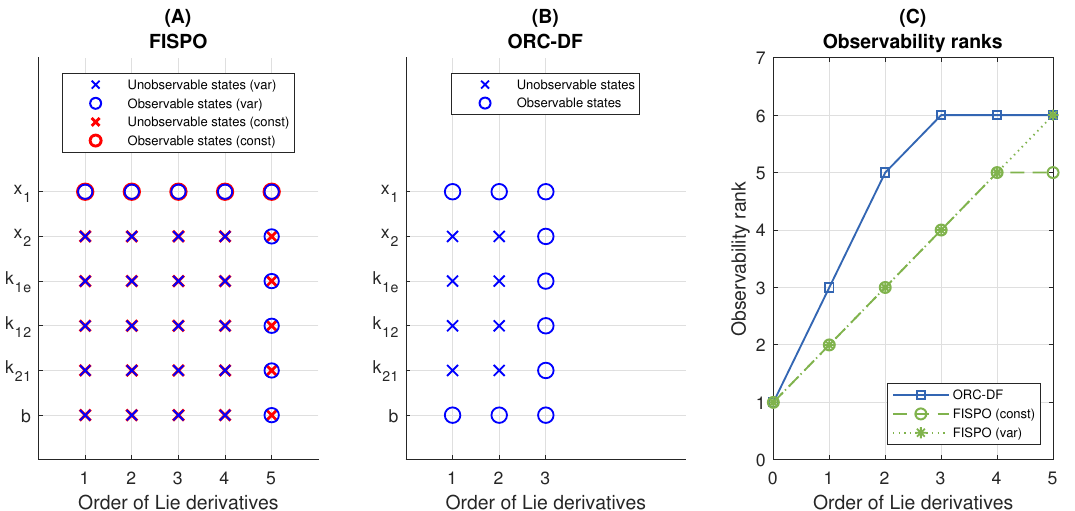
Figure 1. Analysis of the C2M model with the FISPO and ORC-DF algorithm. For FISPO two cases are considered: ˙ u = 0, which is labelled as "(const)", and ˙ u (cid:54) = 0, which is labelled as “(var)”. In the first case, higher order derivatives are assumed to be zero too. ( A , B ) Results of the FISPO and ORC-DF algorithms, respectively: the panel shows the states classified as observable or unobservable as a function of the number of Lie derivatives calculated by each algorithm. ( C ) Observability rank obtained by each algorithm as a function of the number of Lie derivatives. The full rank is equal to the number of states, i.e.,